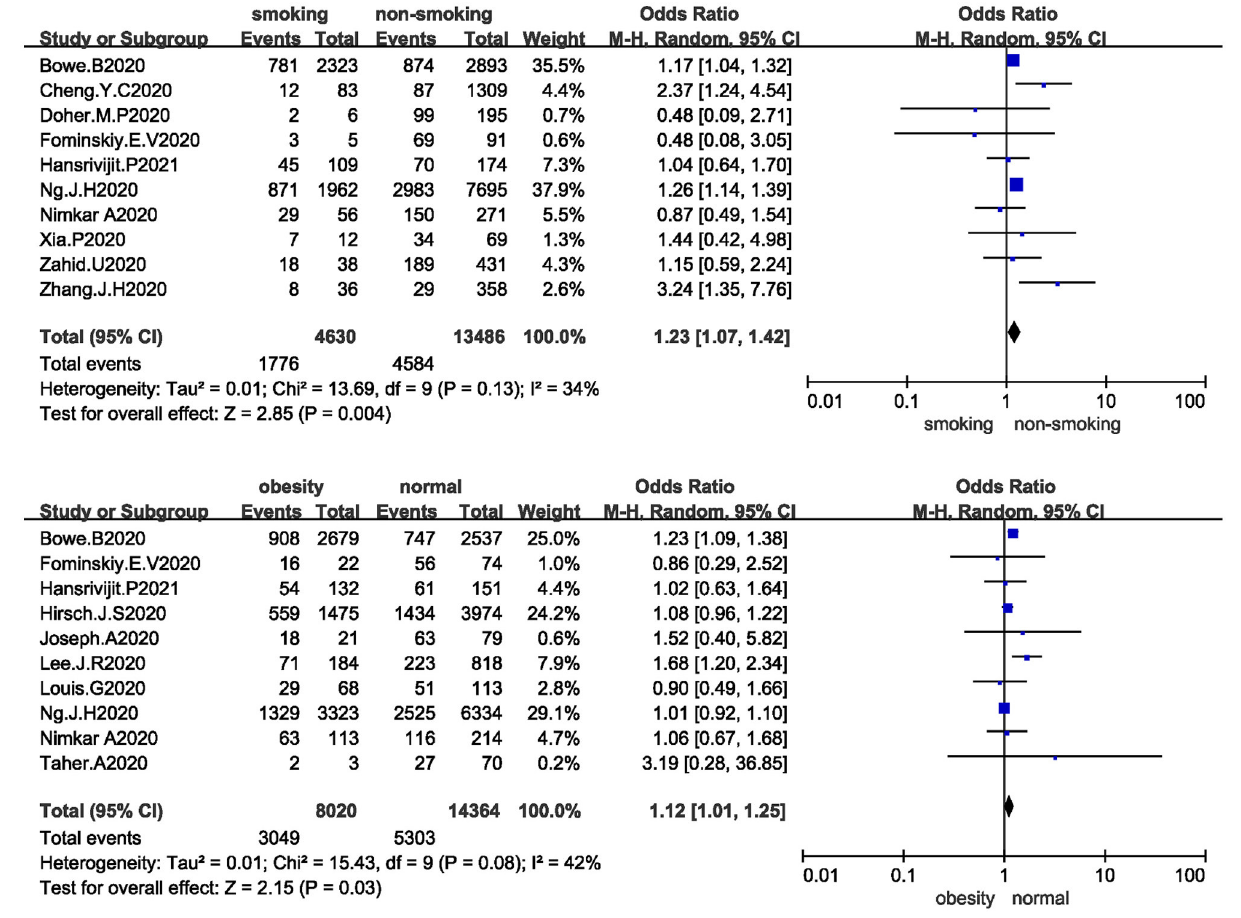
FIGURE 2 | (A) Forest plot showing the relationship between sex and AKI in COVID-19 patients. (B) Forest plot showing the relationship between age and AKI in COVID-19 patients. (C) Forest plot showing the relationship between smoking and AKI in COVID-19 patients. (D) Forest plot showing the relationship between obesity and AKI in COVID-19